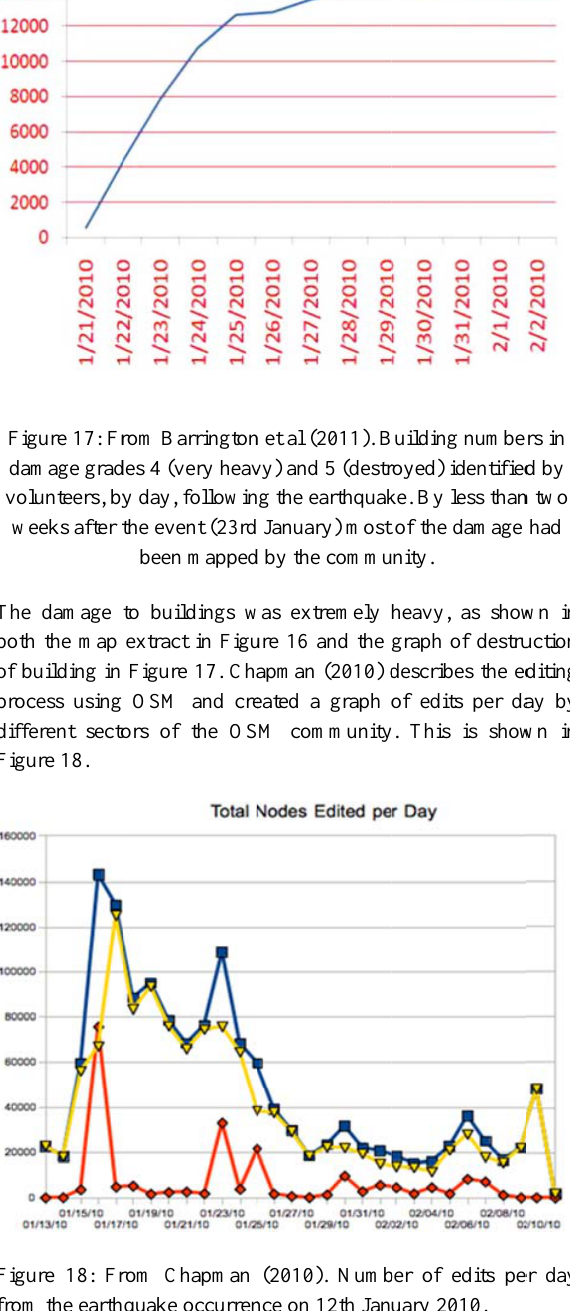
Figure 18: Fr from the earth The blue line i day. This total plus the red li Pre-existing